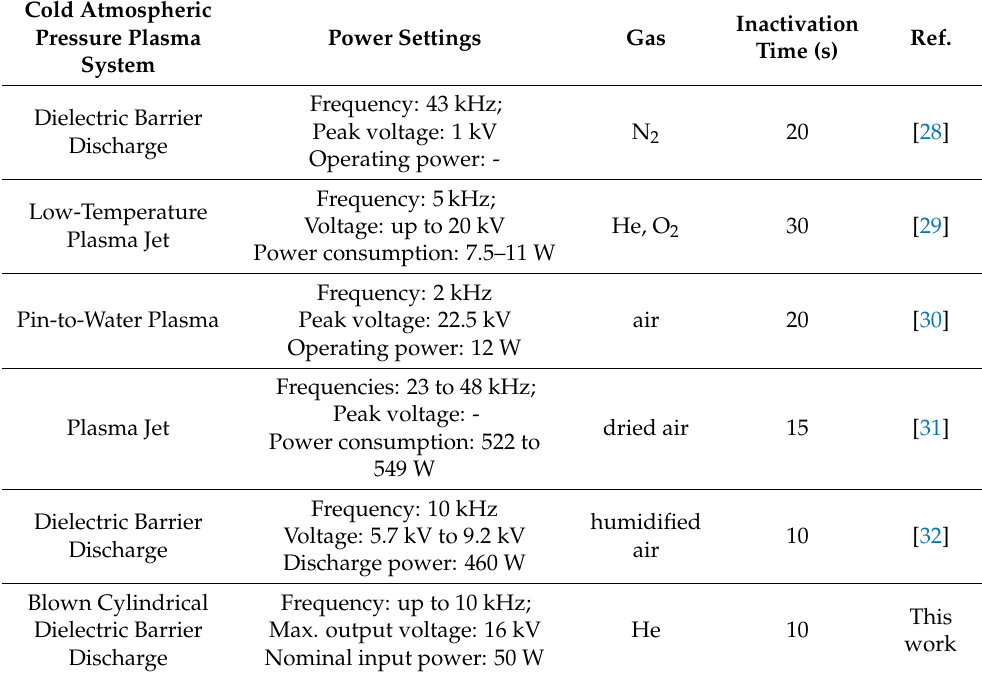
Table 2. The performance of several plasma systems towards E. coli bacteria inactivation.